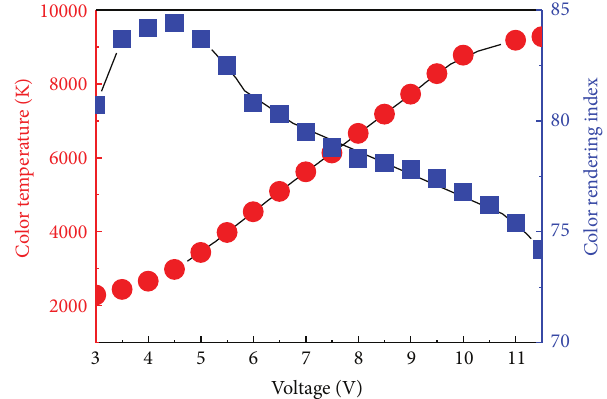
Figure3:Forthestudiedsunlight-styleOLED(Device-I-3),itscolor temperature changes from 2,290 to 9,280 K and color rendering index from 74 to 84.4 as the applied voltage is increased from 3 to 11.5V.